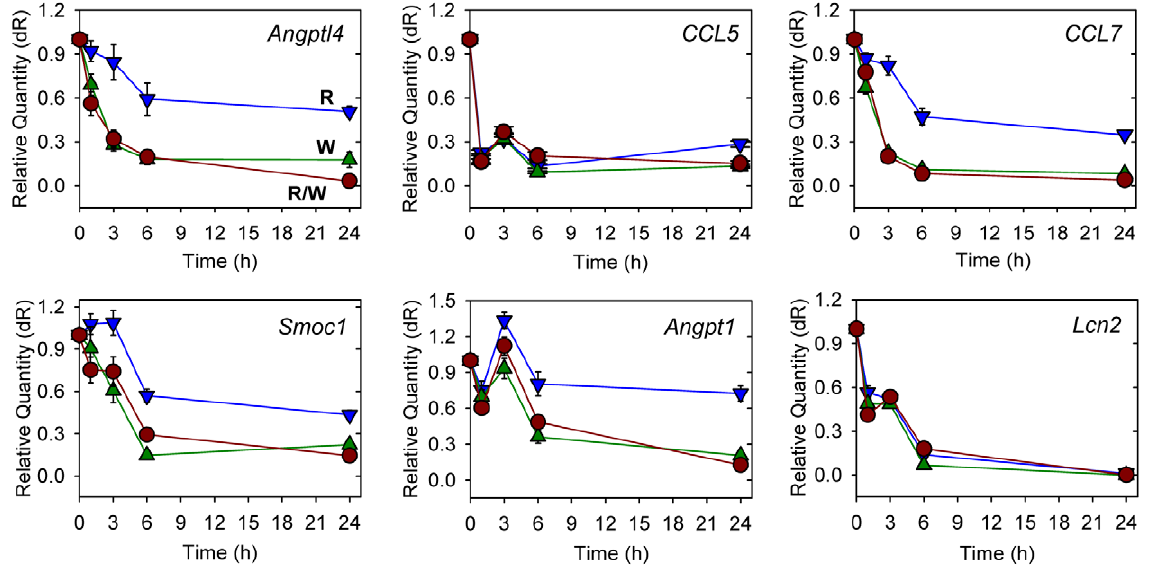
Figure 6. Time-course of Rspo2- and Wnt3a-dependent gene down-regulation in C57MG cells. Quantitative PCR analysis of specific gene expression in response to Rspo2 (100 ng/ml) alone (blue), Wnt3a (100 ng/ml) alone (green) or the two together (red) at the indicated time points. Data are the means + / 2 S.D. (error bars, sometimes too small to be seen) of triplicate measurements from one of several experiments with similar results.